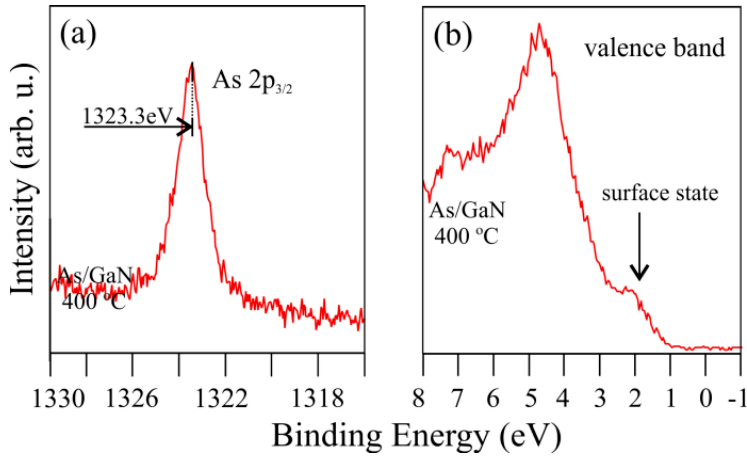
Figure 32. XPS spectra of ( a ) As ‐ 2p 3/2 and ( b ) UPS spectra of the valence band for the annealed As ‐ film ‐ covered GaN(0001) at 400 °C. The amount of residual arsenic is 1 ML. Data previously published in [57].